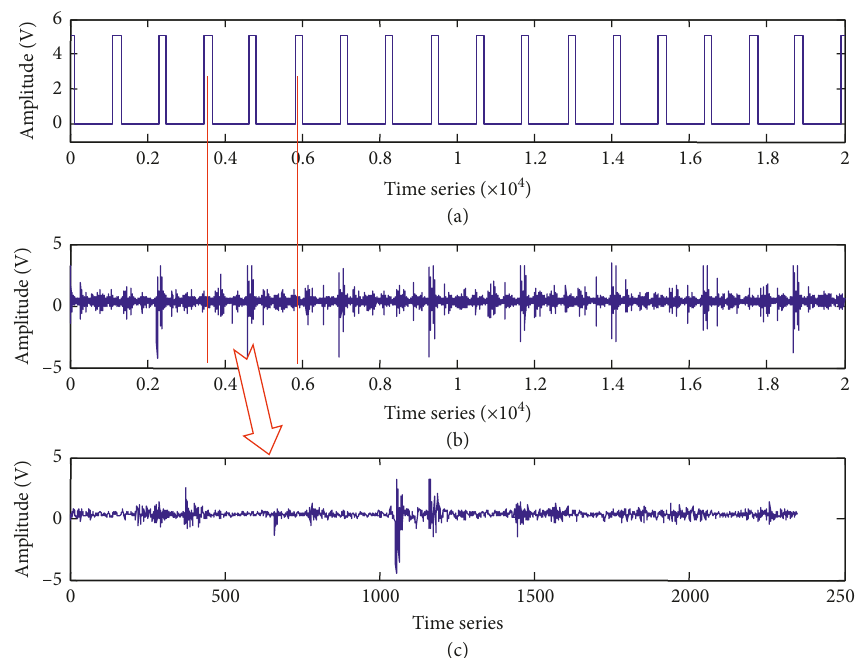
Figure 13: Interception of sixth cylinder head’s vibration signal in the left row. (a) TDC signal. (b) Original vibration signal. (c) Intercepted vibration